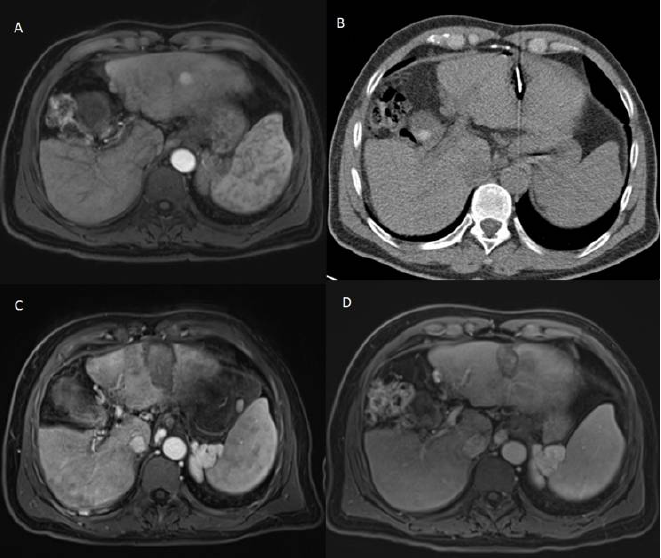
Figure 1. 60 years old male patient with chronic hepatitis B virus, mild liver cirrhosis, and HCC lesion in the left liver lobe, who was treated with MWA. ( A ) Pre-treatment CEMRI showed a hyperenhancement of the lesion in the arterial phase. ( B ) During MWA. ( C ) 24h post-ablation CEMRI showed the completely ablated lesion. ( D ) 2-years post-ablation CEMRI showed a complete remission after MWA. The survival time of this patient was 21 months starting from the date of ablation until last contact.